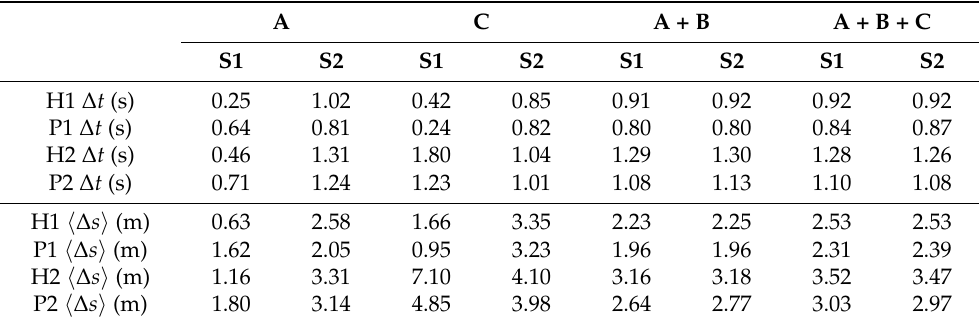
Table 2. Optimized time lags ( ∆ t ) and average spatial offsets (cid:104) ∆ s (cid:105) , for the four ECa signals, consider- ing different combined datasets and nearest neighbor search methods (S1 and S2).